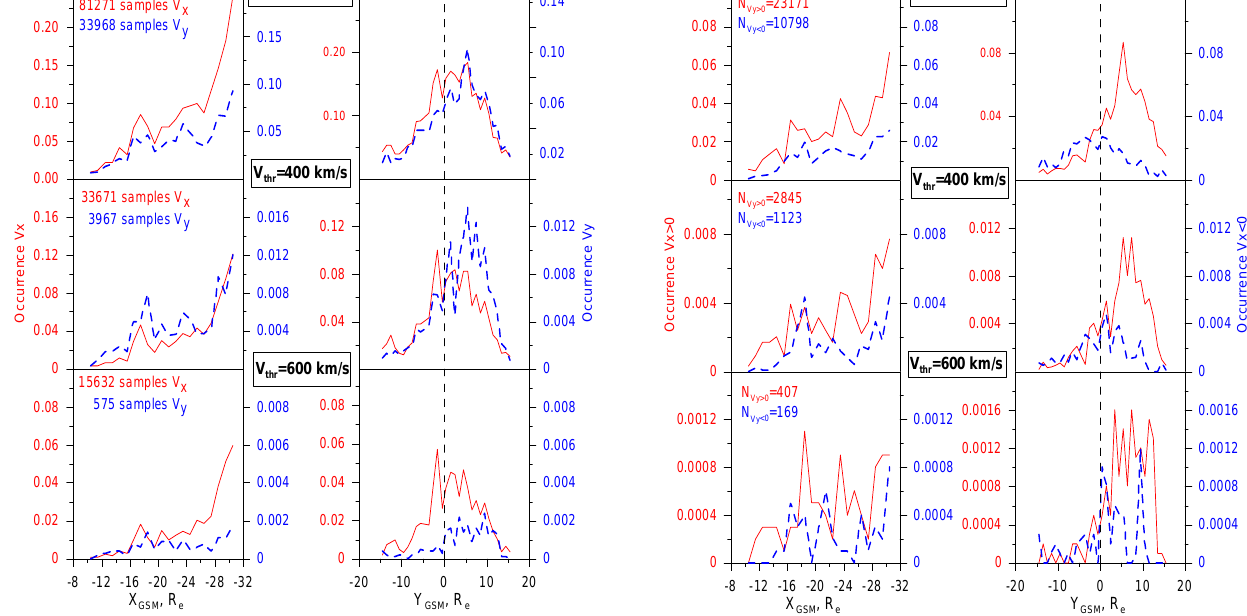
Fig. 2. Occurrence of the | V y | >V thr for V y > 0 (red) and V y < 0 Figure 2 Occurrence of the |Vy|>Vthr for Vy>0 (red) and Vy<0 (blue) samples depending (blue), depending on the X (left column) and Y (right column) on X (left column) and Y (right column) GSM coordinates for different velocity GSM coordinates for different velocity thresholds (200, 400 and thresholds (200 and 400 km/s).